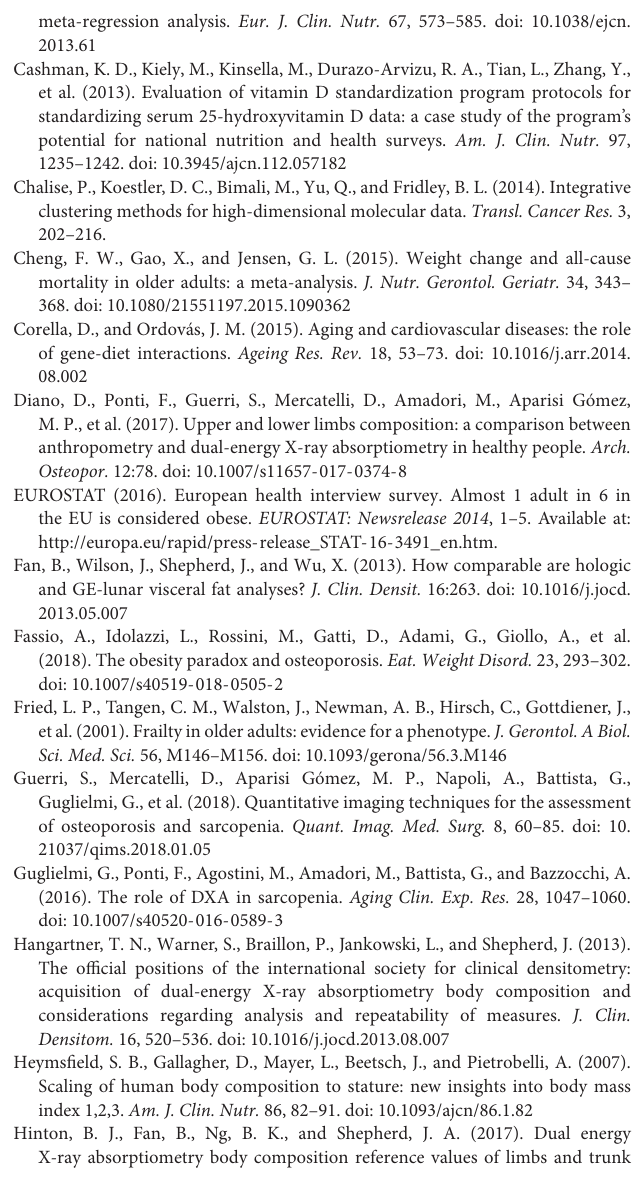
FIGURE S2 | (A,B) Box-plots of participants’ diet assessment divided by sex and country, and significant differences among countries in women and men. Statistical analysis was perfomed by Kruskal–Wallis test ( p -values: ∗ p < 0.05, ∗∗ p < 0.01, ∗∗∗ p < 0.001, ∗∗∗∗ p < 0.0001). FIGURE S3 | (A,B) Box-plots of participants’ Physical Funcitioning divided by sex and country, and significant differences among countries in women and men. Statistical analysis was perfomed by Kruskal–Wallis test ( p -values: ∗ p < 0.05, ∗∗ p < 0.01, ∗∗∗ p < 0.001, ∗∗∗∗ p < 0.0001). FIGURE S4 | (A–O) Box-plots of participants’ Body Composition parameters divided by sex and country, and significant differences among countries in women and men. Statistical analysis was perfomed by Kruskal–Wallis test ( p -values: ∗ p < 0.05, ∗∗ p < 0.01, ∗∗∗ p < 0.001, ∗∗∗∗ p <